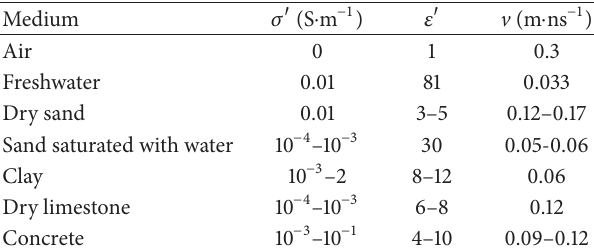
Table 1: Reference values for conductivity, relative permittivity, and wave speed for different media of the studied embankment, from [16].